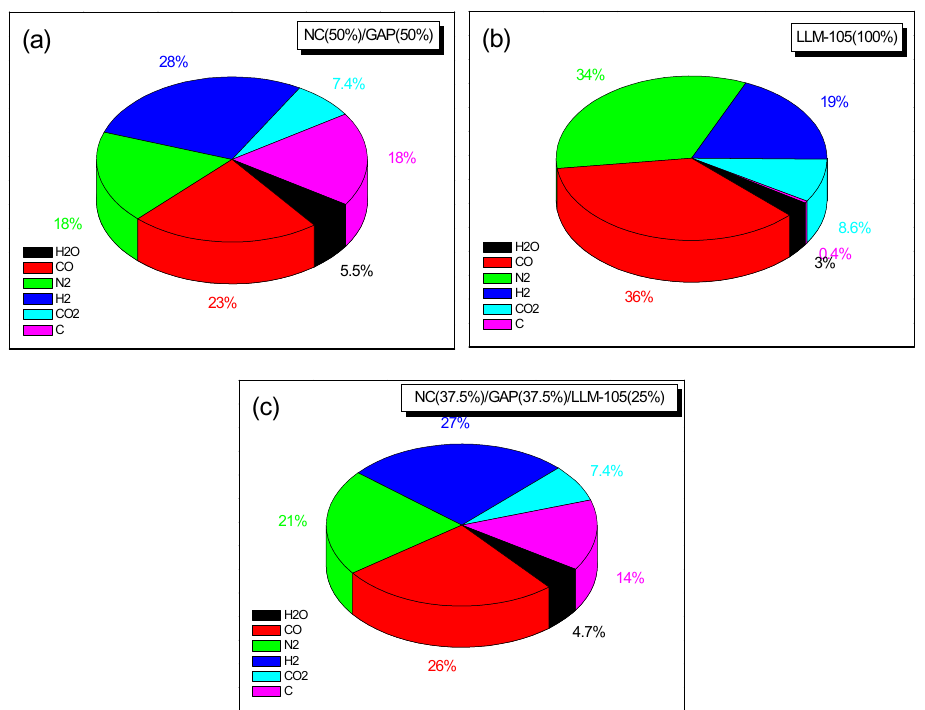
Figure 10. Energy performances of NC/GAP/LLM-105 nanofibers as a function of the weight percentage of LLM-105: ( a ) for I sp ; ( b ) for C* ; ( c ) for T c and ( d ) for M c .